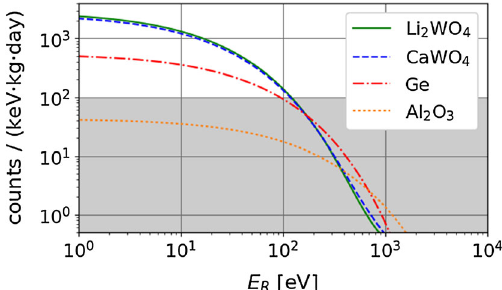
Fig. 1 Differential CE ν NS count rate on Li 2 WO 4 (solid green line), CaWO 4 (dashedblueline),germanium(dash-dottedredline)andAl 2 O 3 (dotted orange line), calculated with the anti-neutrino flux expected at the VNS from both Chooz-B reactor cores. The reactor neutrino flux model follows [3] as parameterized in [4]. The NUCLEUS experiment aims to reach a background count rate of 100counts/(keV kg day), indi- cated by the gray